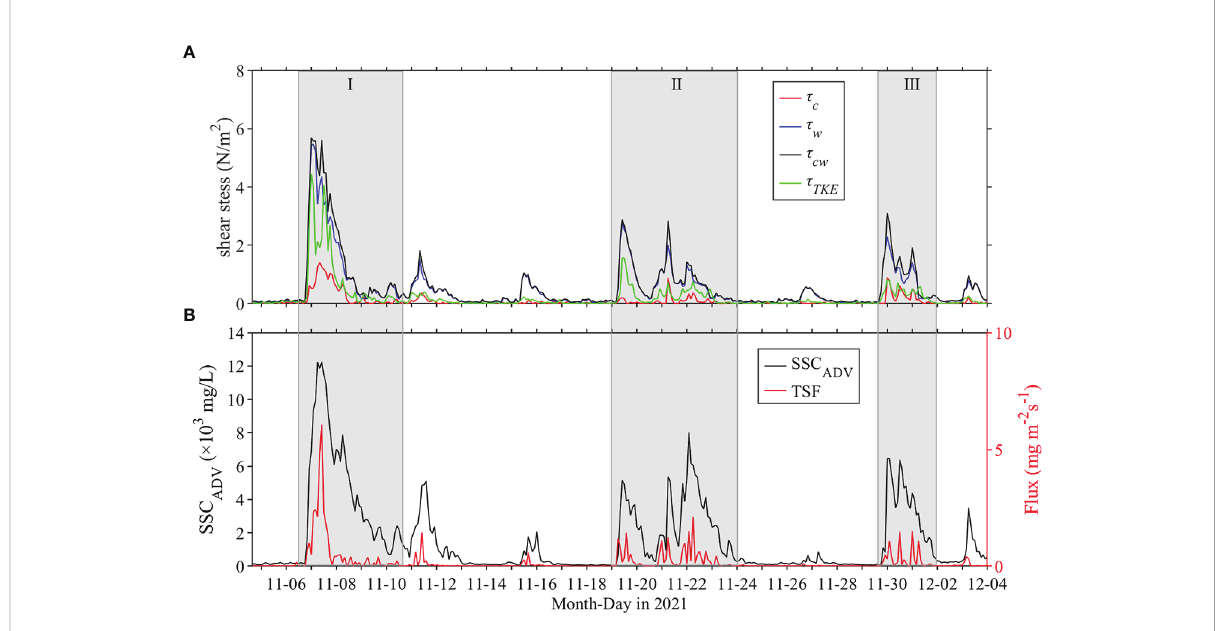
FIGURE 9 Time series of (A) current-induced bed shear stress (red line), wave-induced bed shear stress (blue line), combined wave-current bed shear forces (black line), turbulent-induced shear stress (green line), and (B) SSC ADV (black line) and turbulent-induced sediment vertical diffusive fl ux (red